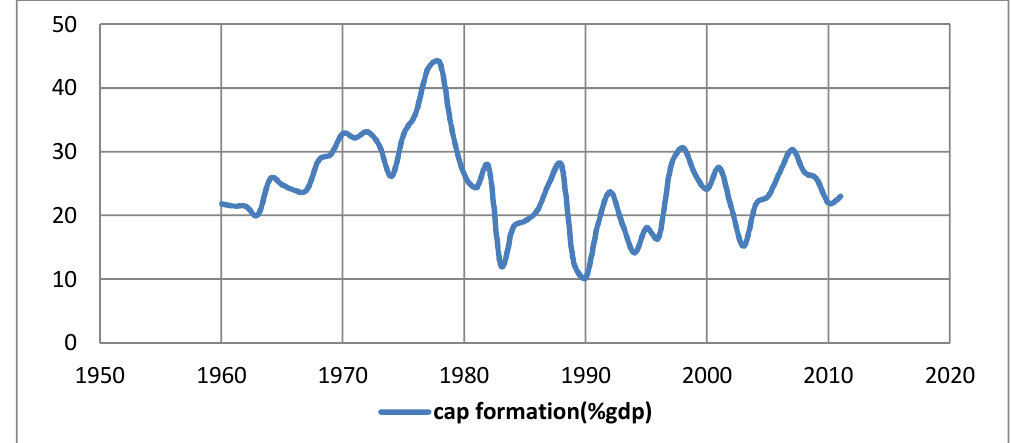
Figure 2: Capital Formation (% gdp) in Venezuela during 1960-2011